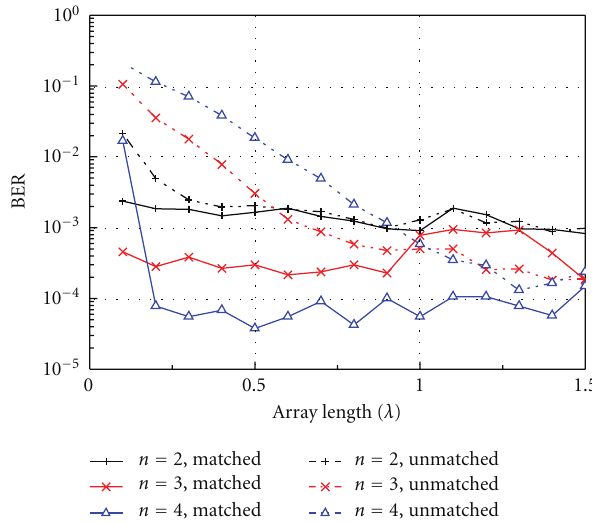
Figure 4: Imacts of spacings between antenna elements on BER performances of the SM MIMO systems with linear arrays in Rayleigh senarios.